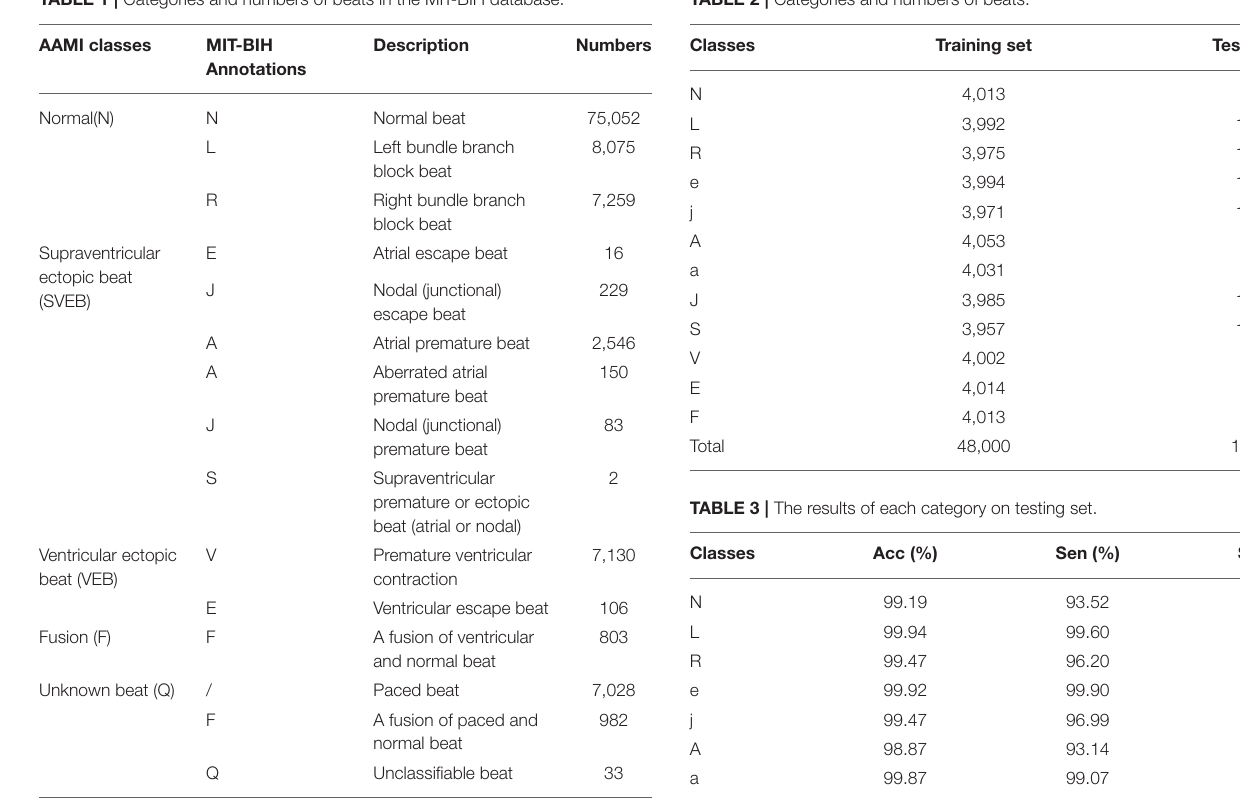
TABLE 1 | Categories and numbers of beats in the MIT-BIH database. TABLE 2 | Categories and numbers of beats.